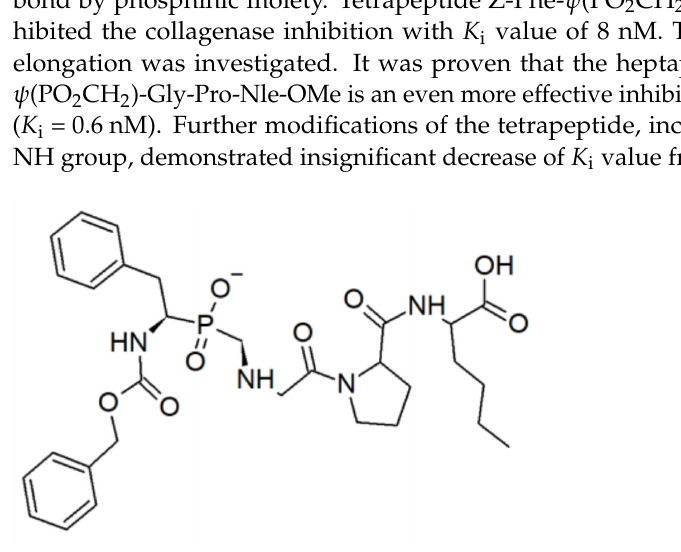
Figure 4. Phosphinic peptide Z-Phe- ψ (PO 2 CH 2 )-Gly-Pro-Nle, a potent inhibitor of collagenase, reported by Yiotakis et al.